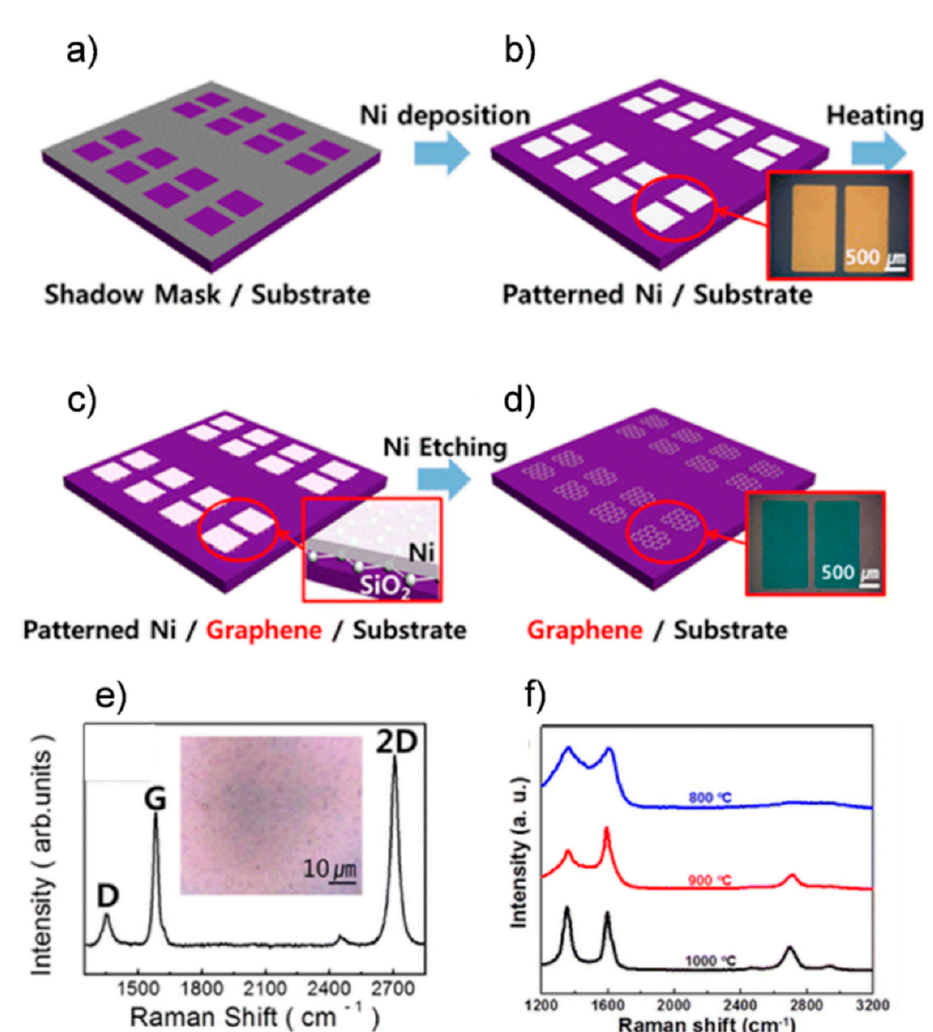
Figure 2. ( a – d ) Graphical representation of the experimental procedure of interfacial growth of graphene without any source feeding; ( e ) Raman spectrum of as-grown graphene on SiO 2 /Si substrate from ( a – d ); ( f ) Temperature functional growth of graphene on SiO 2 /Si substrate and evolution of Raman spectra. ( a – e ) Reproduced with permission from [71]. Copyright American Chemical Society, 2012; ( f ) Reproduced with permission from [78]. Copyright American Chemical Society,